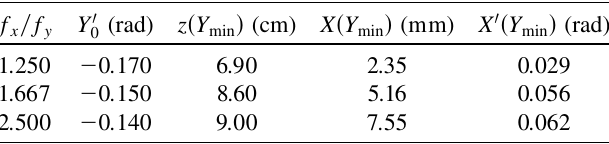
TABLE II. Properties of the optimal focus as a function of lens